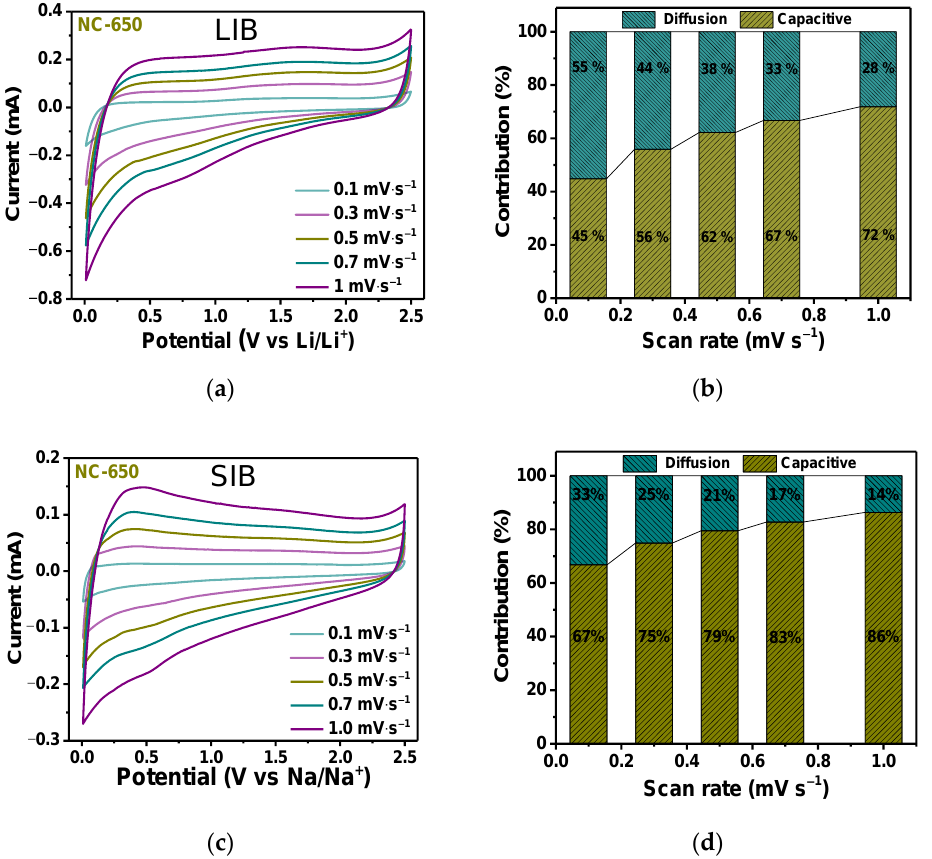
Figure 6. Electrochemical kinetic analysis for NC-650 in lithium-ion batteries ( upper ) and sodium-ion batteries ( down ): ( a , c ) CV curves at different scan rates; ( b , d ) diffusion-controlled and capacitive contribution ratios at various scan rates.